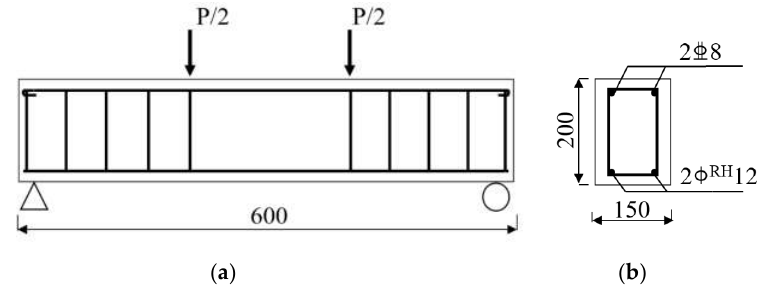
Figure 1. Details of test specimens (unit: mm): ( a ) Geometry; ( b ) Midspan section.